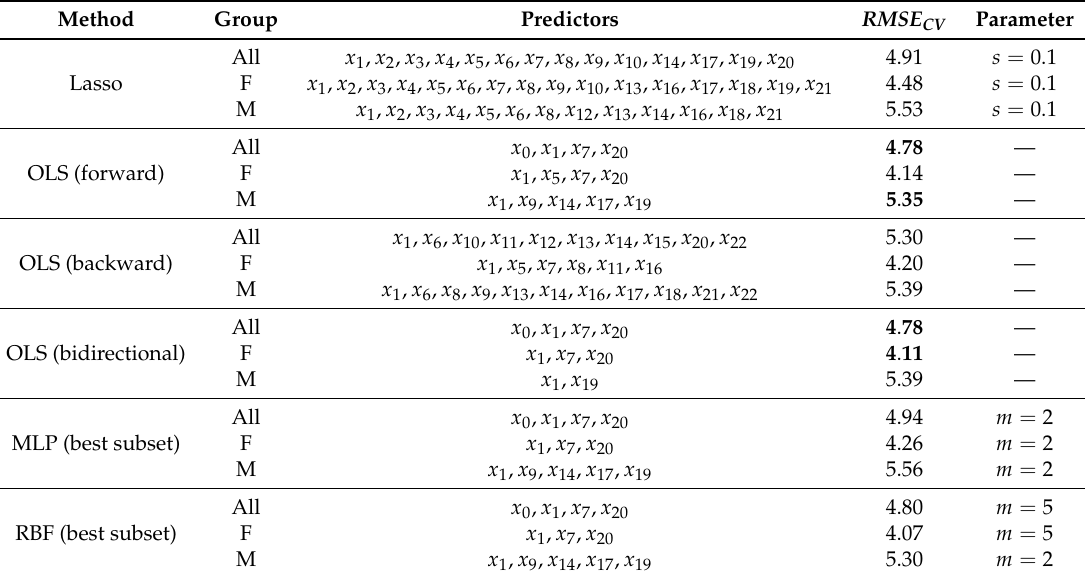
Table 4. Mathematical models with variable selection.